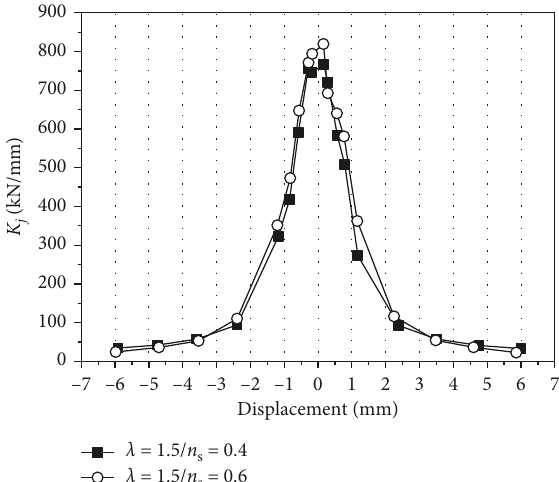
Figure 24: Stiffness degradation curves of the RC columns under different axial compression